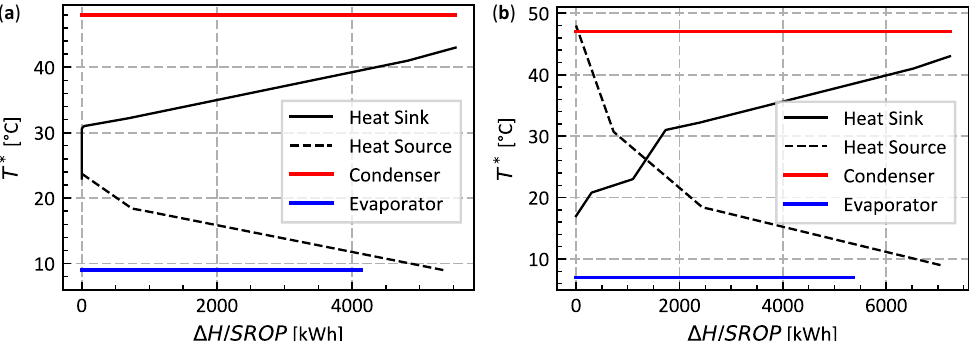
Figure 12. Inverted Residual ISSP of the industry case study for an IHR of ( a ) 1700 kWh and ( b ) 0